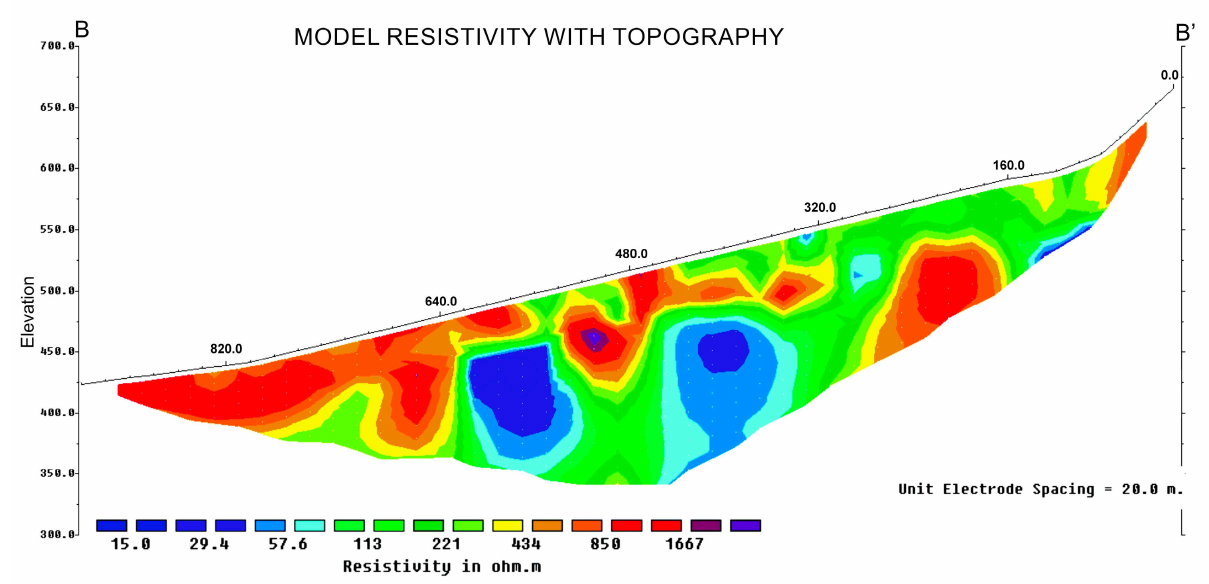
Figure 4. Model of resistivity of the B-B’ (ERT) longitudinal section.